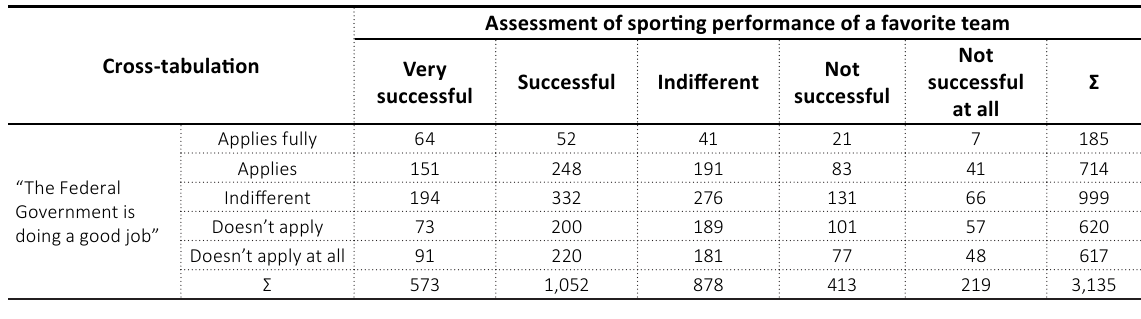
Table 7. Results of Chi 2 -tests and T -tests concerning non-sports